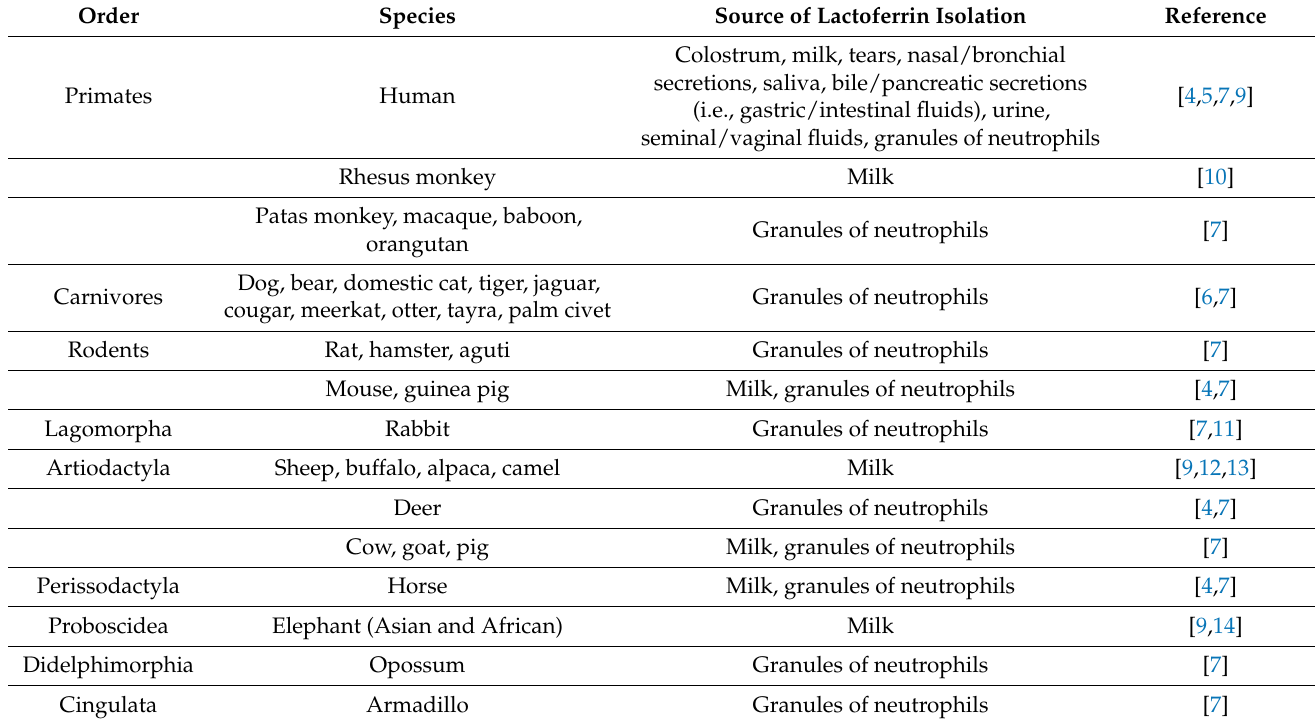
Table 1. Mammalian species from where lactoferrins have been identified and